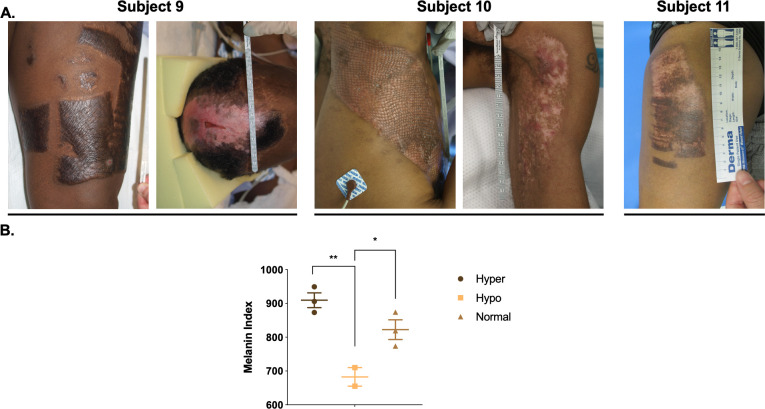
Heterogeneous dyschromia with hyper- and hypo-pigmentation develops after burn injury in patient HTS.Examples of HTS from Subjects 9–11 from Table 2 (A). SCC non-invasive skin probe was used to measure melanin in the different pigmentation phenotypes (B) (mean ± SEM, n = 3 scars). *p<0.05, **p<0.01.